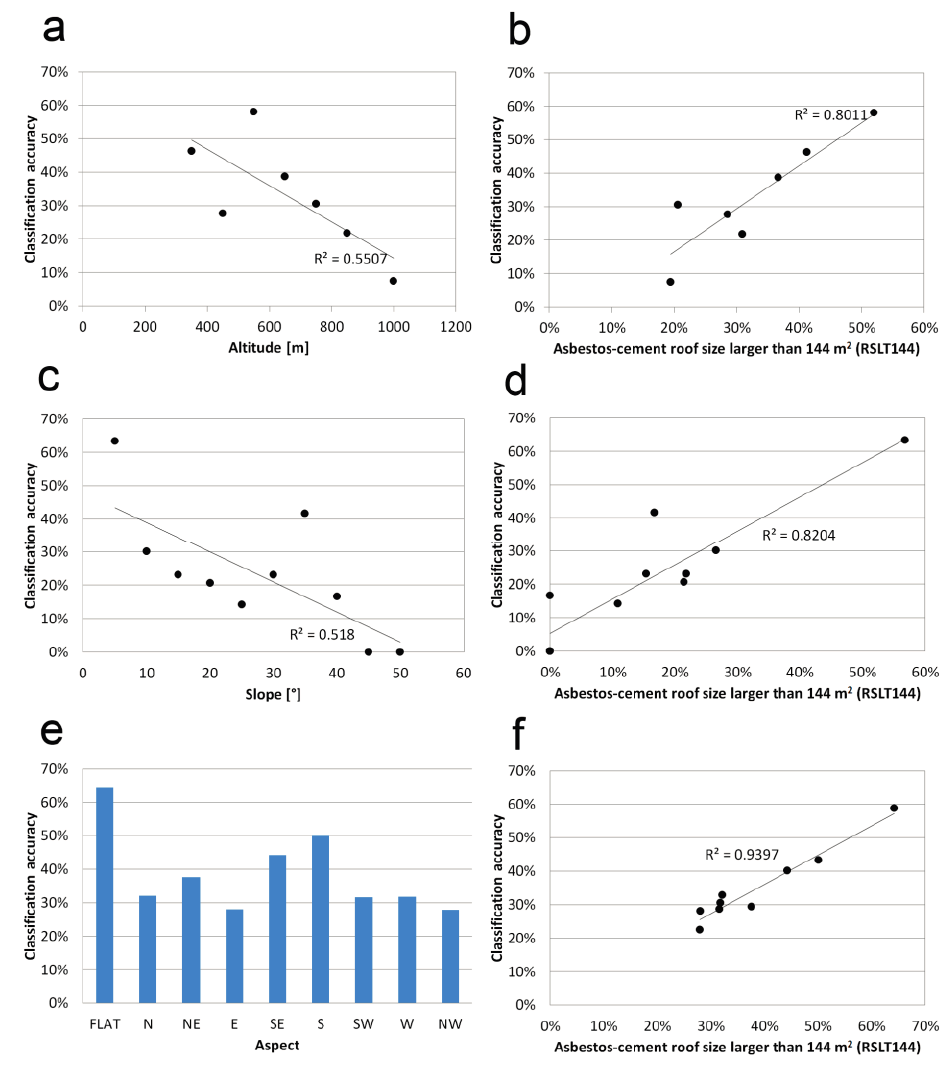
Figure 7. Correlation between classification accuracy and topographic features: ( a ) classification accuracy vs . altitude; ( b ) classification accuracy vs . percentage